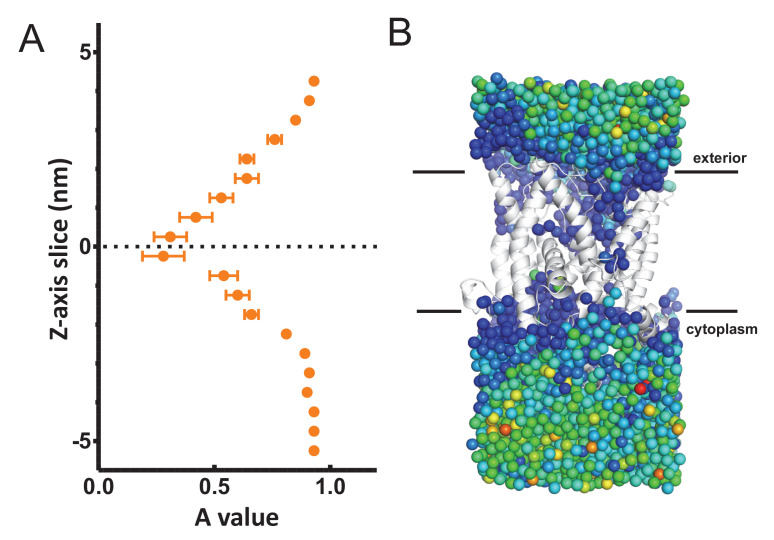
Analysis of waters through SecYEβ.(A) Average MSD values along the length of the SecYEβ channel in isolation (Serek et al., 2004). Data analysed as per Figure 3B. This data agrees with previously published data (Capponi et al., 2015), and shows no asymmetry across the channel. (B) The raw MSD data for one simulation set (from the 1 µs time point) plotted onto the oxygens for each water molecule. The dark blue waters around SecY represent a lower MSD than the green/yellow waters in the bulk solvent.